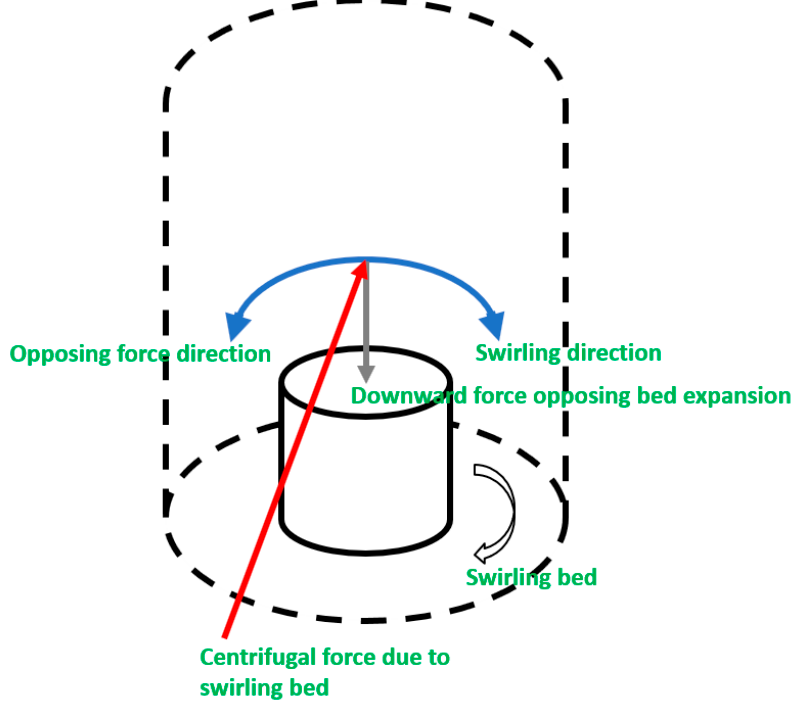
Figure 6. Free-body diagram of forces acting on swirling bed material.